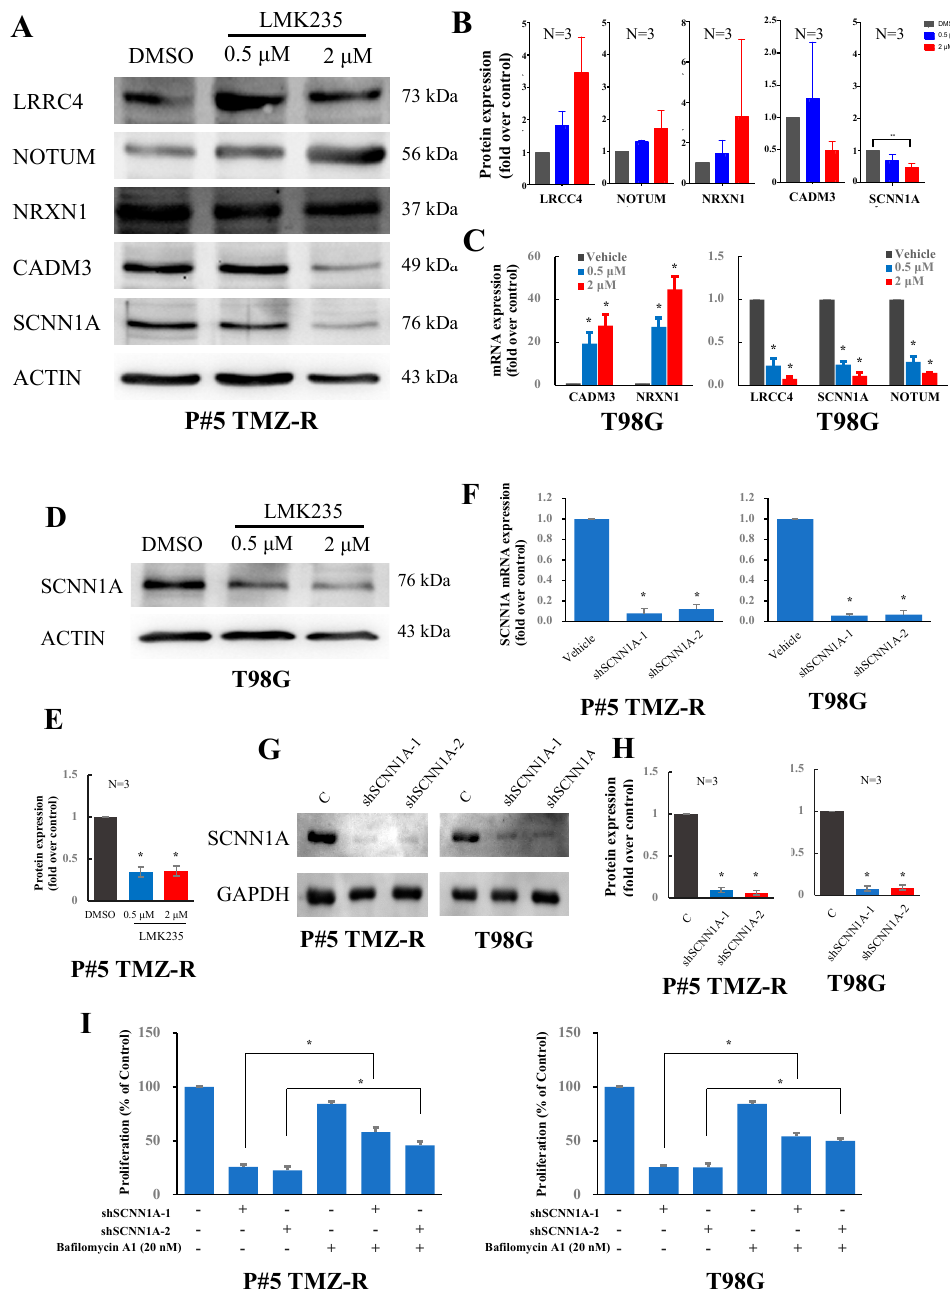
Figure 5. The role of SCNN1A in LMK235-treated GBM cells. ( A ) Cells were treated with LMK235 at 0.5 µM and 2 µM for 72 hr and analyzed by immunoblotting against LRRC4, NOTUM, SCNN1A, NRXN1, and CADM3. T98G cells were analyzed by qPCR ( C ) and by immunoblotting ( D ) after LMK235 treatment. The SCNN1A mRNA and protein expression levels were determined by qPCR ( F ) and immunoblotting ( G ) in shSCNN1A -infected cells, respectively. ( I ) SCNN1A silenced cells or scramble cells were incubated with bafilomycin A1 at the indicated doses and then analyzed by cell viability assays. Quantification of each band in ( A , D , G ) was shown in ( B , E , H ), respectively. ACTIN and GAPDH were used as internal controls for immunoblotting and qPCR, respectively. * indicates comparison with vehicle; mean ± SEM. * p < 0.05. The uncropped blots are shown in File